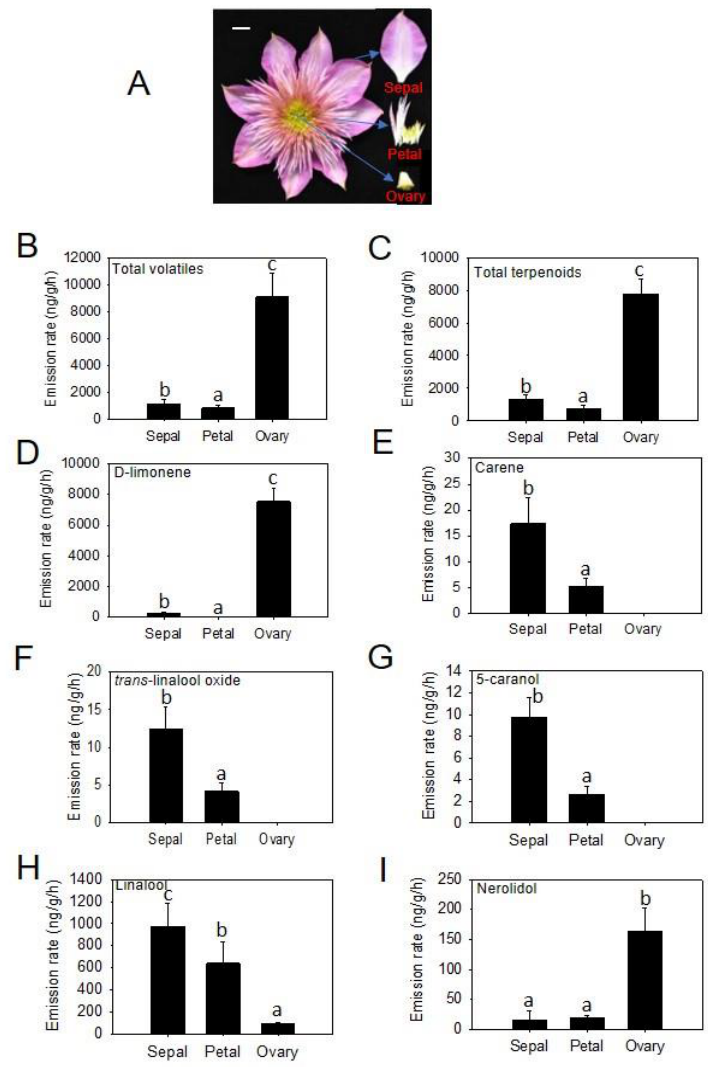
Figure 2. Volatile emission from di ff erent parts of C. florida ‘Kaiser’ flowers. Representative images of the intact flower and three detached organs of C. florida ‘Kaiser’ ( A ). Emission rate of total volatiles ( B ) and total terpenoids ( C ) from three detached organs in C. florida ‘Kaiser’. Individual terpenoids from three detached organs in C. florida ‘Kaiser’: limonene ( D ), carene ( E ), trans -linalool oxide ( F ), 5-caranol ( G ), linalool ( H ), and nerolidol ( I ). Data were obtained through semi-quantification and are presented as mean ± SE ( n = 3). Di ff erent letters in B – G denote statistically significant di ff erences among the means according to ANOVA analysis ( p <